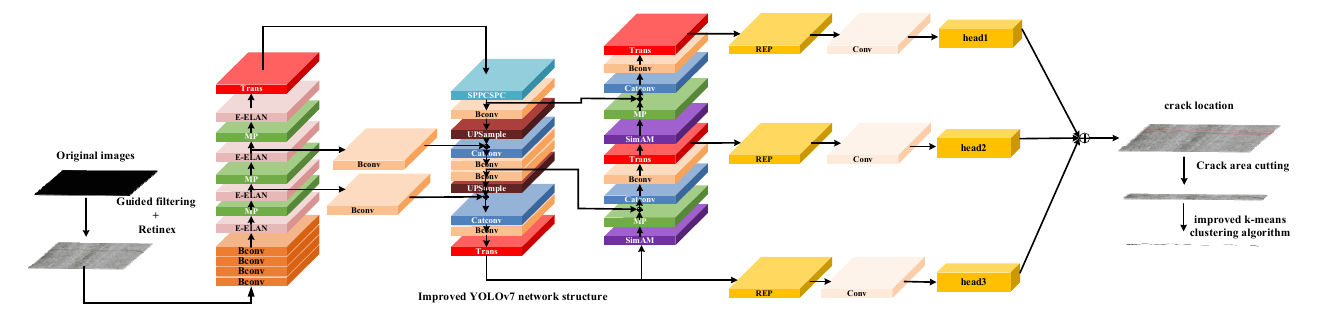
Figure 1. The network structure diagram of the proposed method.